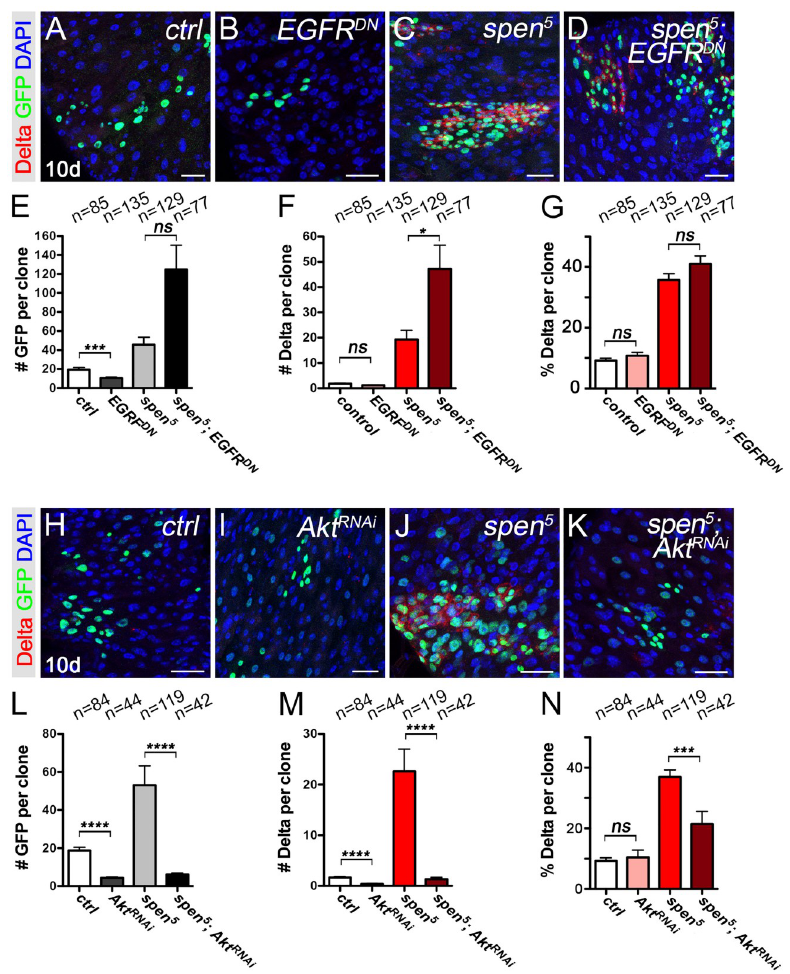
clones, (C) , spen 5 clones, and (D) spen 5 ; EGFR DN clones, 10d after heat shock (AHS). (Delta+, RED; GFP, GREEN; DAPI, BLUE,) (E) Quantification of: cells per clone, (F) Dl+ cells per clone, and (G) Dl cell proportion per clone in A-D. (H-K) Genetic interaction between spen and AKT (H) Wild-type clones, (I) , AKT RNAi clones, (J) , spen 5 clones, and (K) spen 5 ; AKT RNAi clones, 10d after heat shock (AHS). (Delta+, RED; GFP, GREEN; DAPI, BLUE,) (L) Quantification of: cells per clone, (M) Dl+ cells per clone, and (N) Dl cell proportion per clone in A-D. p < 0.01, �� . p < 0.001, ��� . p < 0.0001, ���� . Mann-Whitney Two-Way ANOVA test. One cell clones were excluded in this quantification as only stem cell clones were analyzed. Error bars represent the Standard Error of the Mean (sem). Scale bar: 25 μ m.